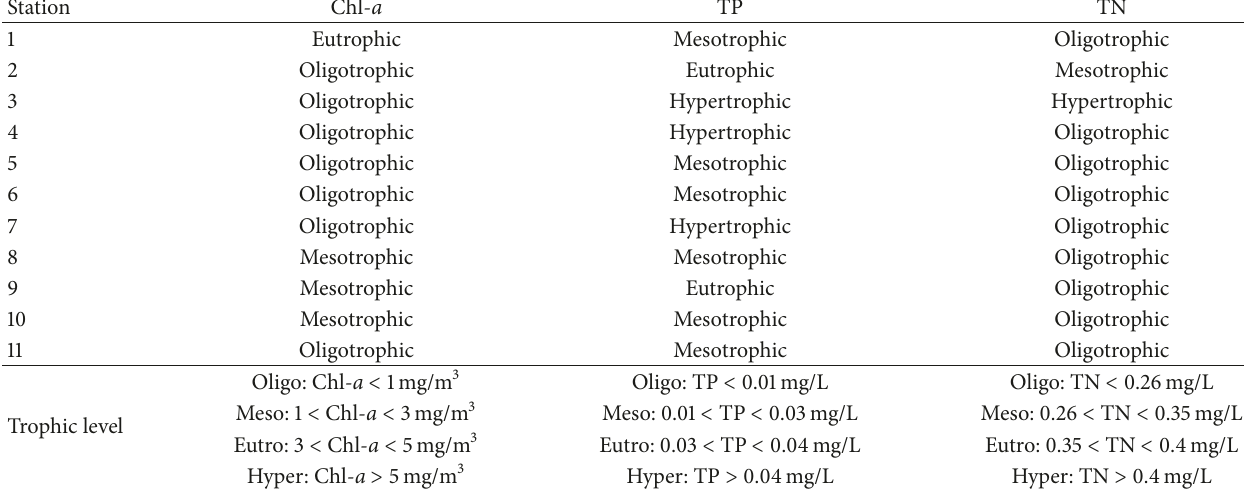
Table 2: Trophic status of Sarawak coastal water